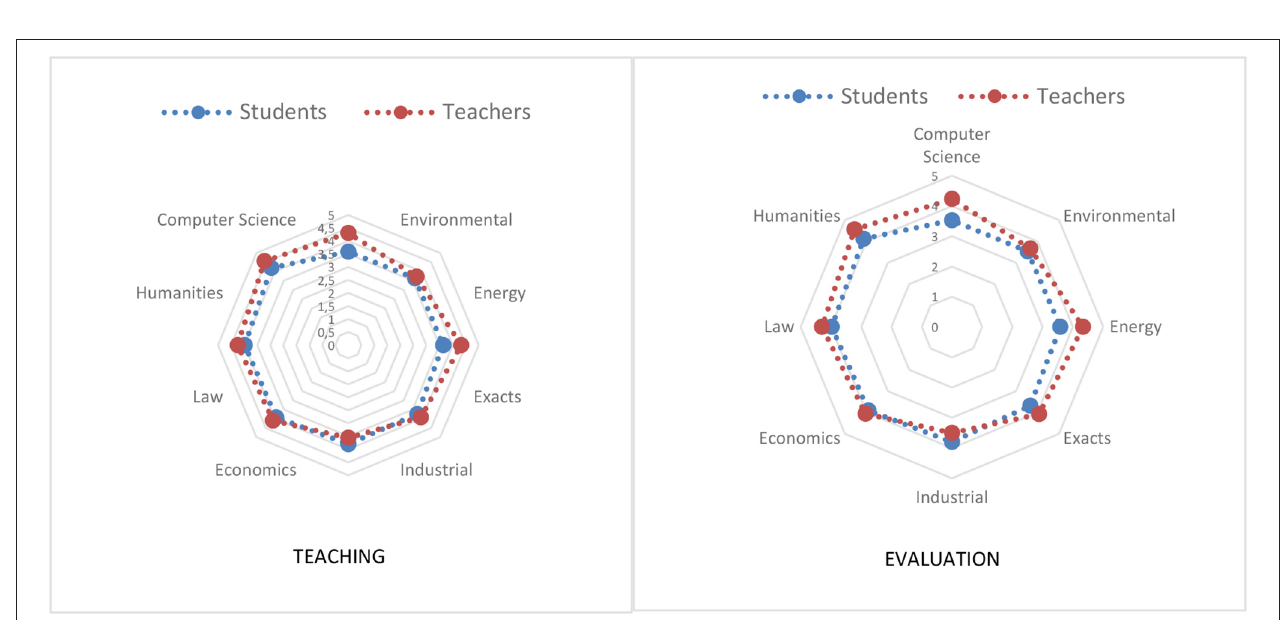
FIGURE 1 | Degree of knowledge about the transversal teaching of the ARC.